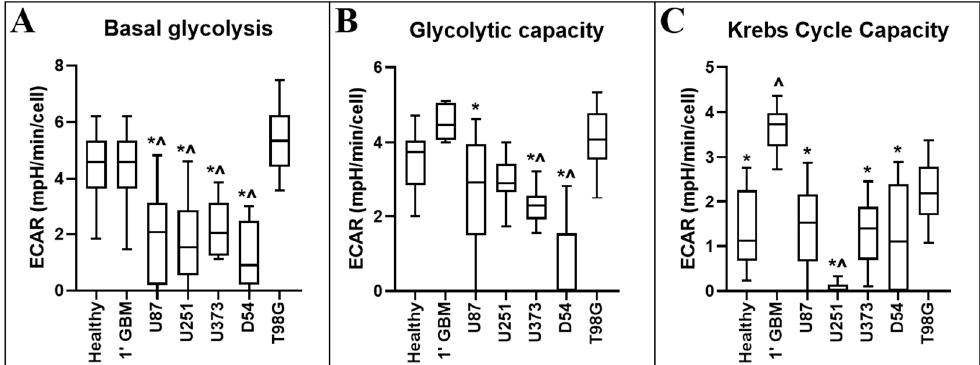
Figure 4. Comparison of ECAR-related metabolic parameters of primary neural and GBM cells, and GBM cell lines. ECAR-related metabolic parameters: ( A ) basal glycolysis (the basal ECAR); ( B ) glycolytic capacity (the ECAR after oligomycin); and ( C ) Krebs cycle capacity were calculated from measurements obtained using information from the Seahorse Bioscience Metabolic Flux Analyser Mito Stress Kit. Data presented represent the mean, with quartile 1 and 3 marked. For all data points in cell lines, n = 5; in primary healthy cells, n = 8; in primary GBM cells, n = 13; plated in triplicate. * represents statistically significant difference with primary glioblastoma control (1 ′ GBM) ( p ≤ 0.05). ^ represents statistically significant difference with between primary healthy mixed neural control (1 ′ Healthy) ( p ≤ 0.05).